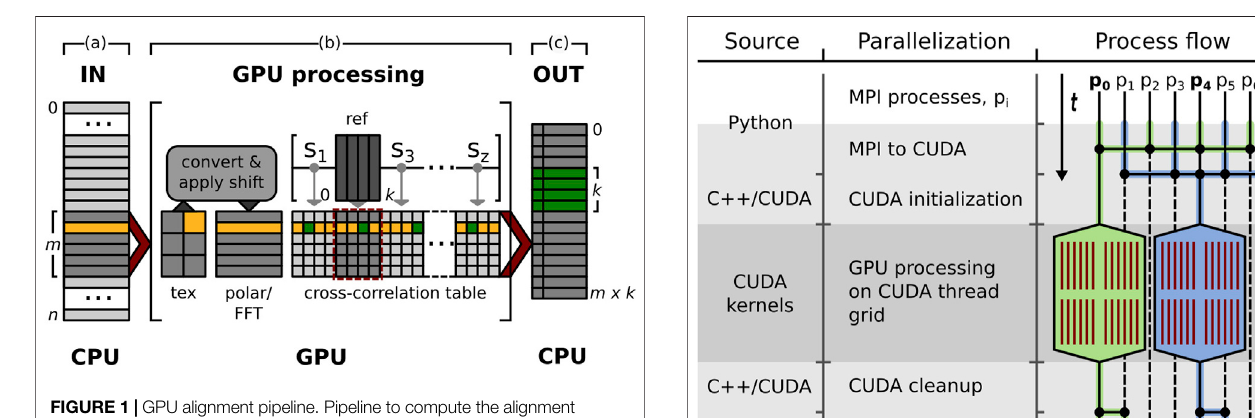
FIGURE 1 | GPU alignment pipeline. Pipeline to compute the alignment parameters to bring a stack of n particles into register with k references, each. To help illustrate the overall process, the memory used by the same image throughout the different memory buffers of the pipeline is highlighted in yellow. The memory to store the computed alignment parameters of this particle and all references are marked in green. (A) IN: Stack of n input particles. The pipeline processes substacks of size m (dark grey) of the overall data stack until all data is processed. (B) GPU processing: The images of the next substack to be processed are fi rst transferred to the GPU and stored in CUDA texture memory ( tex ). A CUDA kernel then converts all images to their polar representation while simultaneously applying a translational shift s l ∈ [s 0 , ...,s alignment parameter tuples to best align p i with each of the k references. This results in an output stack of m x k alignment parameter tuples per substack.